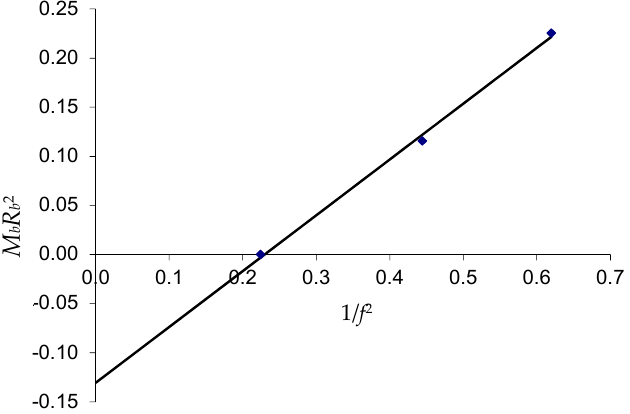
Figure 9. Linear approximation of M b R b 2 vs. 1/ f 2 for experimental values of the wheel’s rotating mass moment of inertia.